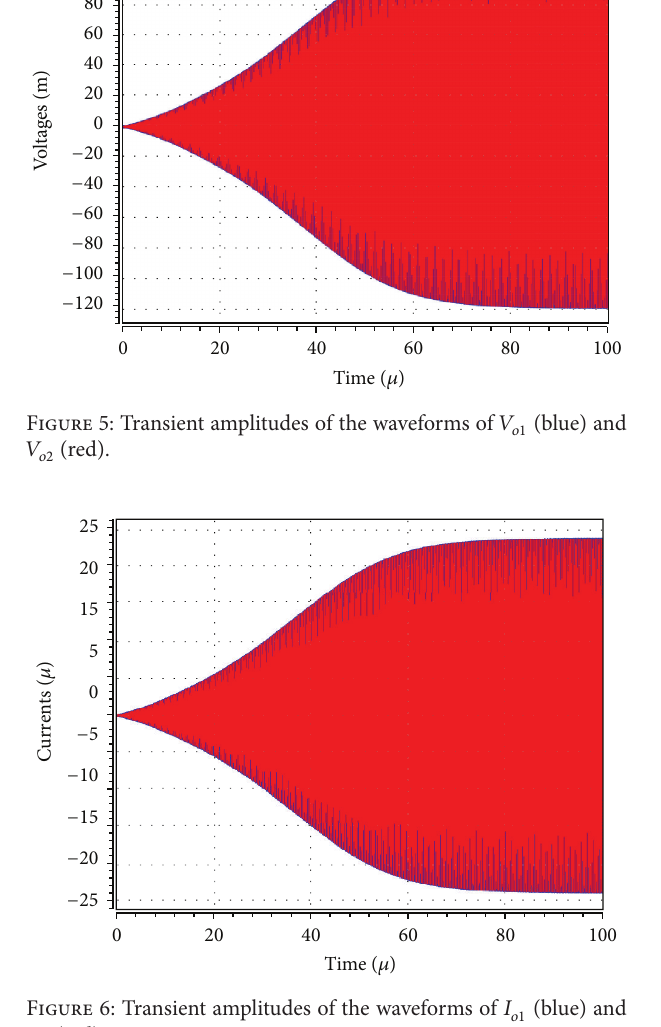
Figure 8: Simulated quadrature current output waves of 𝐼 𝑜1 (blue) and 𝐼 𝑜2